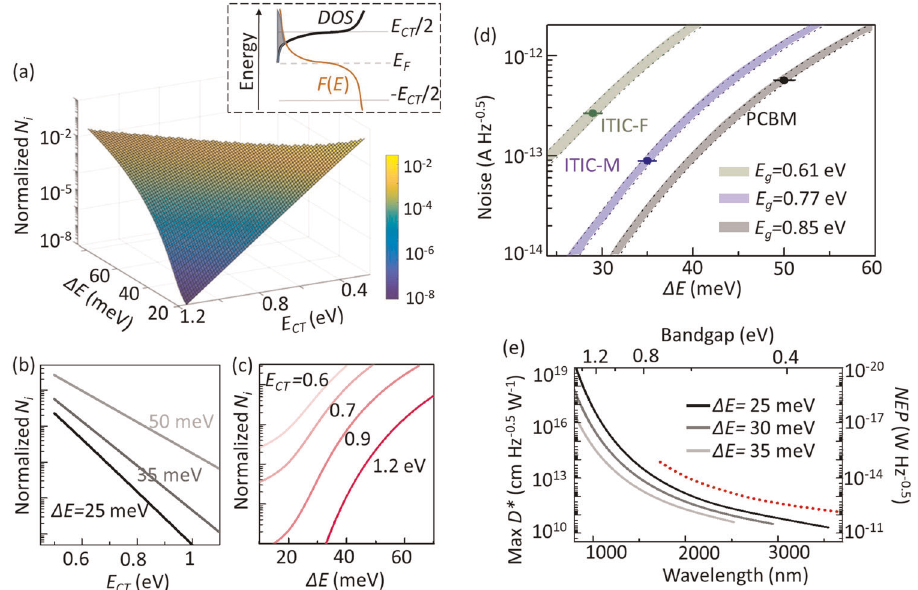
Fig. 5 Physical model of thermal noise. a Normalized thermally generated carrier concentration as a function of the effective bandgap or the bandtail disorder in organic photodiodes. The inset shows the parameters for calculating the carrier concentration indicated by the shaded area. To offer different perspectives, b and c display the data in a as contour plots. d The predicted thermal noise from our model. The dots indicate the measured noise in photodiodes with different acceptors. The horizontal bars on the dots represent ±1 meV uncertainties in the measured Δ E values. The color bands show the predicted noise with E CT held at the indicated values within ±0.01 eV. e The upper bound for detectivity and noise-equivalent power for organic infrared photodiodes with disorder. The red dotted line shows the detectivity of a background-limited infrared photodiode with the background at 300 K and the fi eld of view of